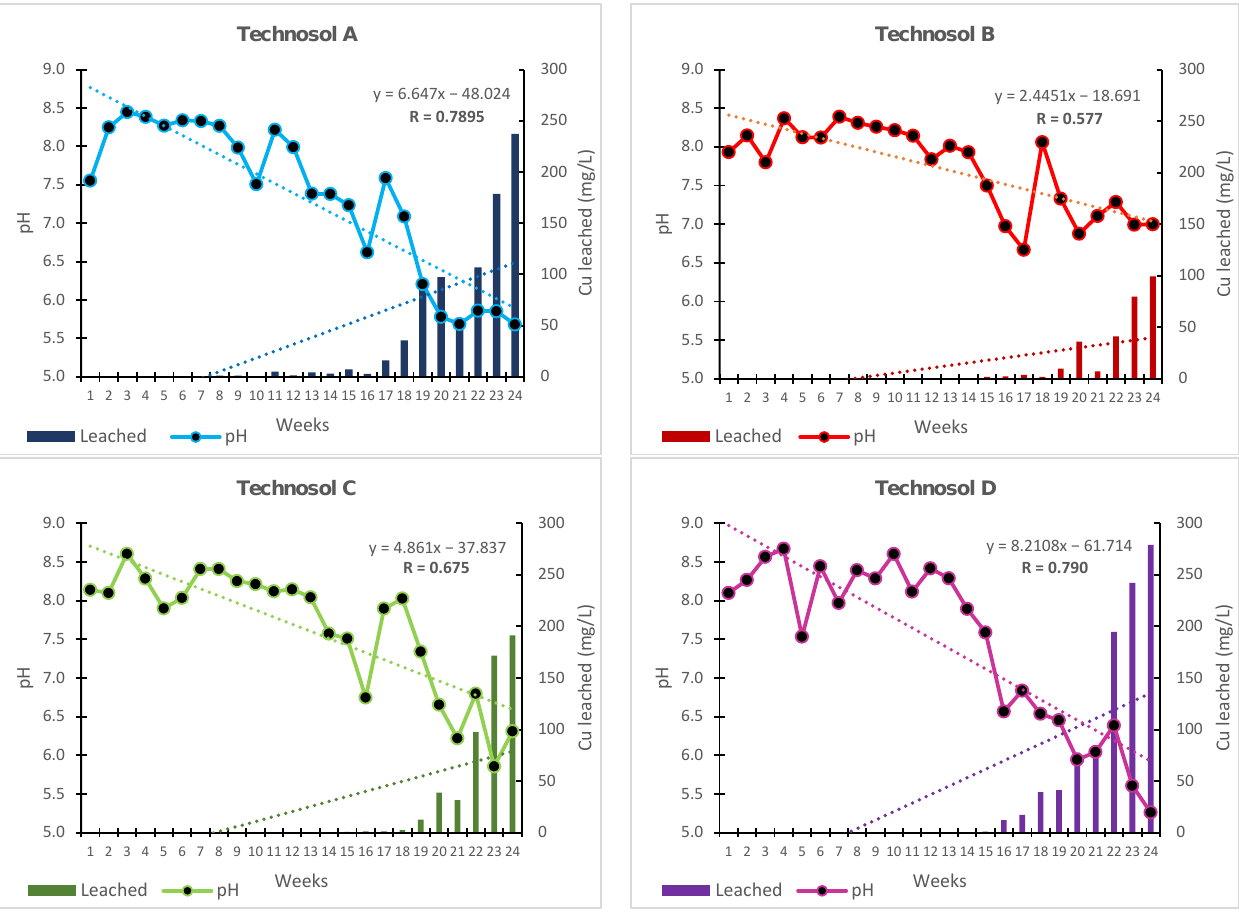
Figure 5. Pearson correlation (R) between pH and Cu leached (mg Cu/L) from Technosols, showing a positive correlation between pH decrease and the increase of copper leached from Technosols. The dashed lines demonstrate the correlation tendency.